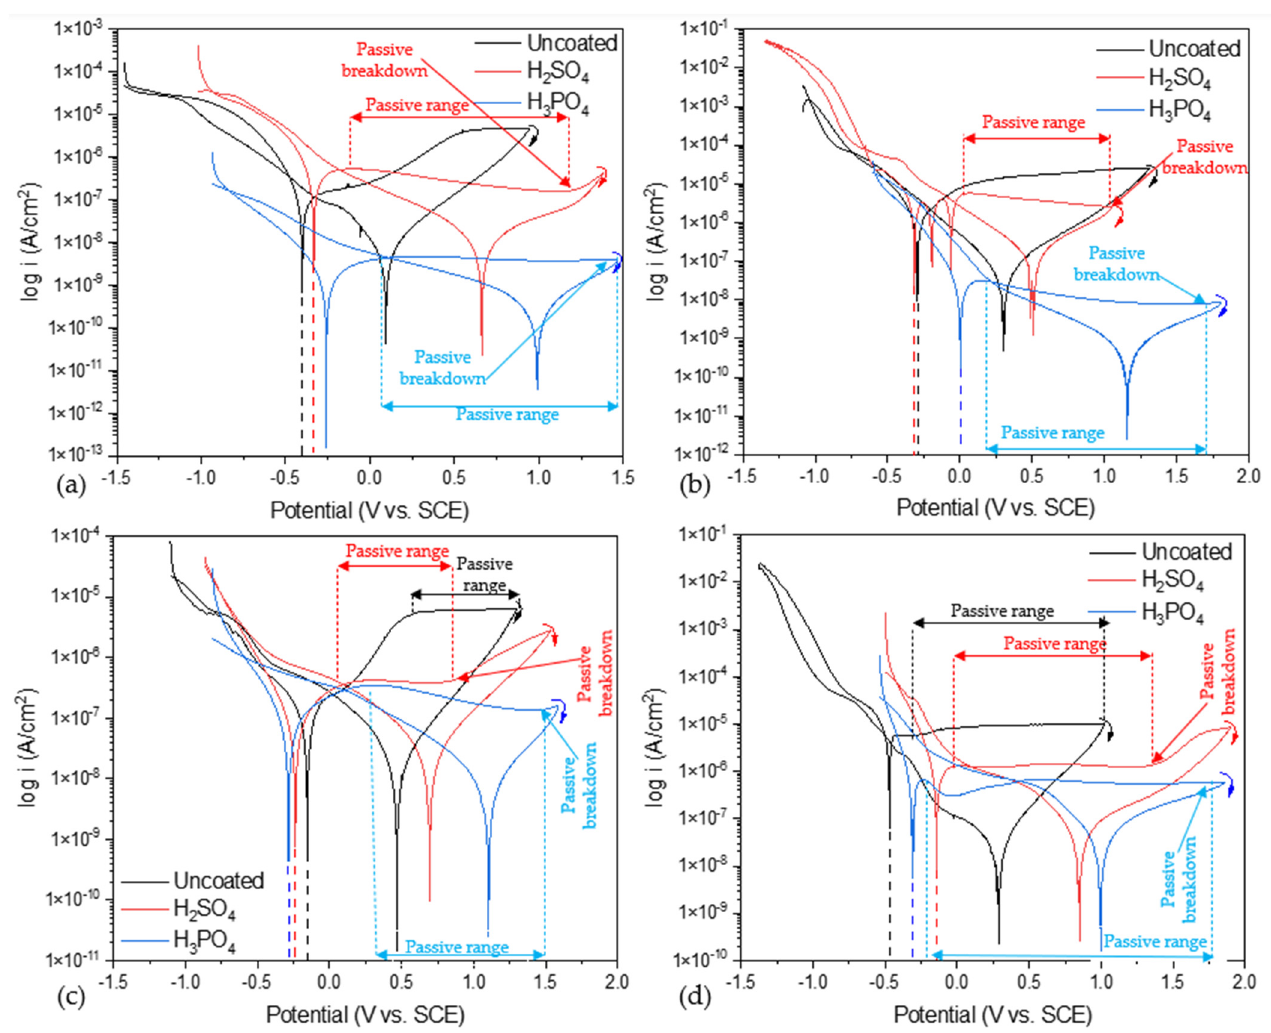
Figure 5. CPP of alloys and anodized samples (a ) Ti-6Al-2Sn-4Zr-2Mo in NaCl, ( b ) Ti-6Al-2Sn-4Zr- 2Mo in H 2 SO 4 , ( c ) Ti-6Al-4V in NaCl, and ( d ) Ti-6Al-4V in H 2 SO 4